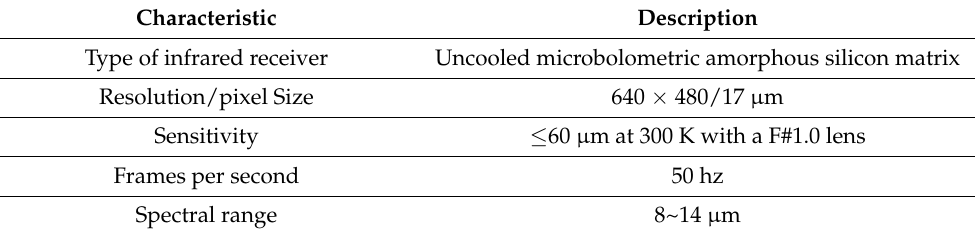
Table 3. Specifications of thermal-imaging module ATOM